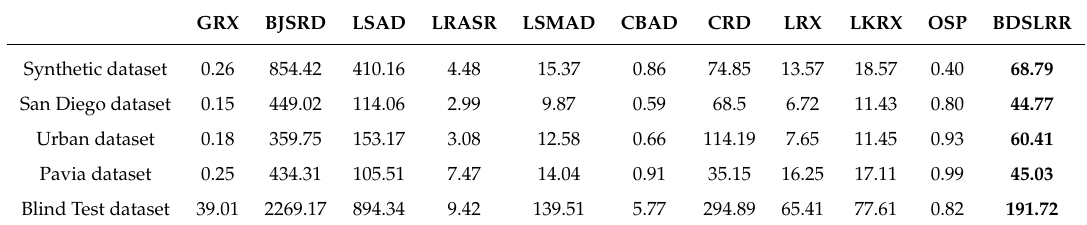
Table 7. Running Times (s) of All Methods for All Datasets.